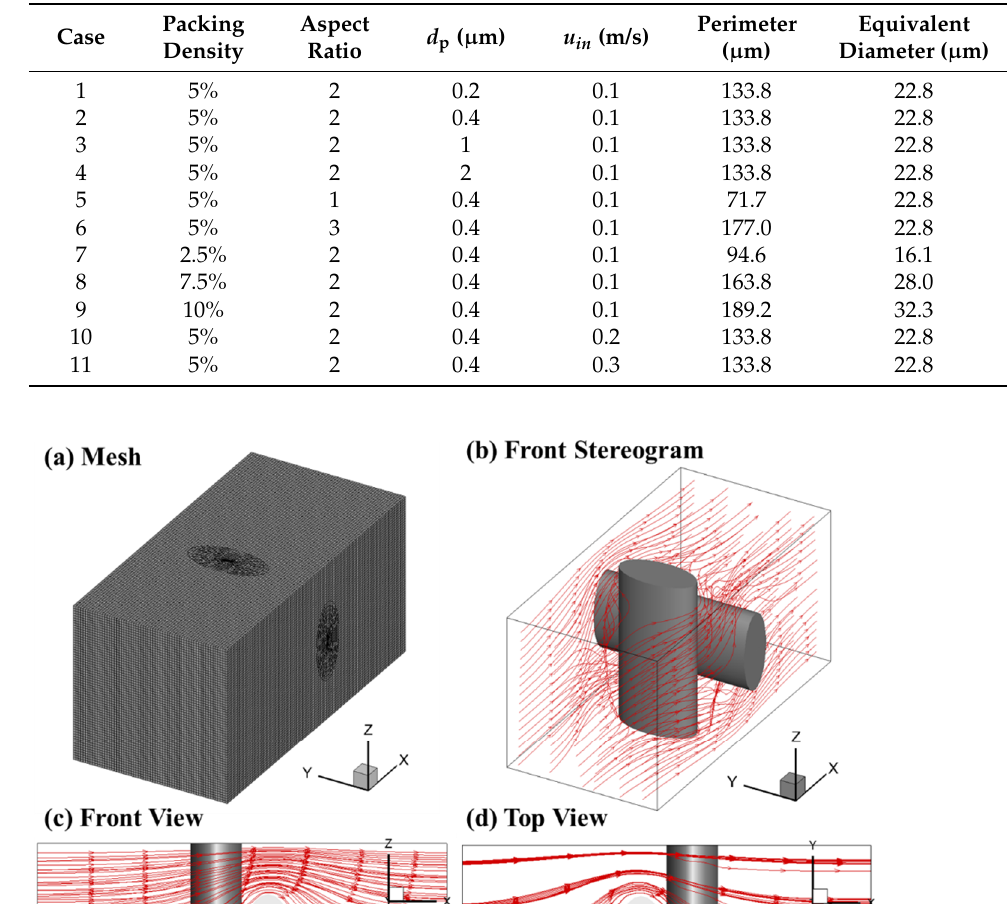
Table 2. Parameters of the simulation cases.